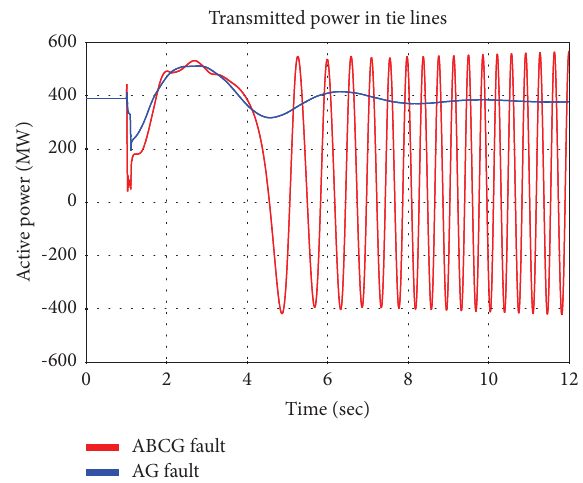
Figure 17: Efect of changing network confguration on transmitted power.